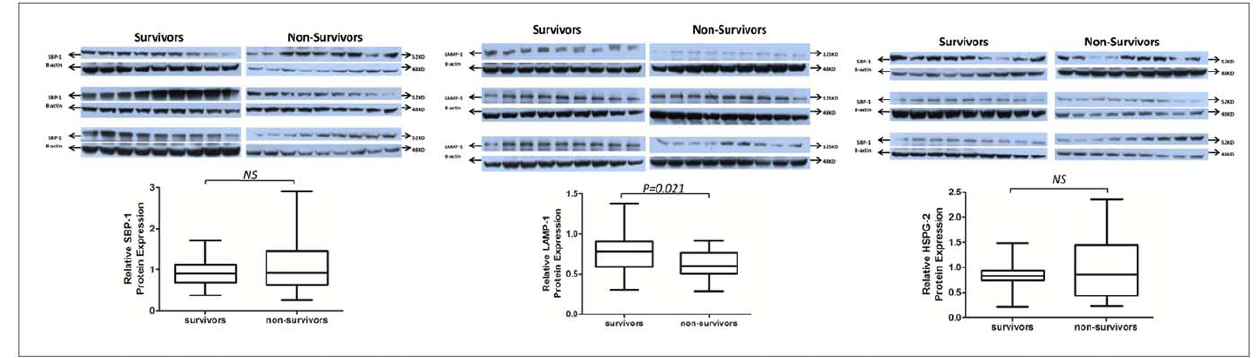
Figure 5. Western blot validation of three candidate markers in individual sepsis patients with different prognoses. (A) Relative protein expression of SBP-1. The survivor group and non-survivor groups were 0.938 6 0.347 and 0.945 6 0.602 ( p . 0.05), respectively. (B) Relative protein expression of LAMP-1. The survivor group and non-survivor groups were 0.752 6 0.246 and 0.617 6 0.166 ( p , 0.05), respectively. (C) Relative protein expression of HSPG-2. The survivor and non-survivor groups were 0.802 6 0.282 and 0.880 6 0.606 ( p . 0.05),